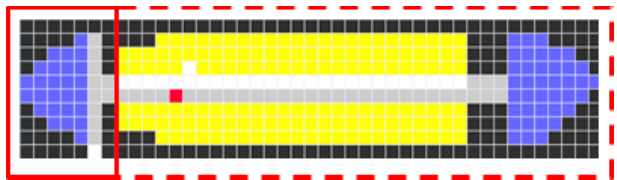
Figure 17. Areas evaluated by “pre-seat” (solid box) and “seating” (dashed box) rules.